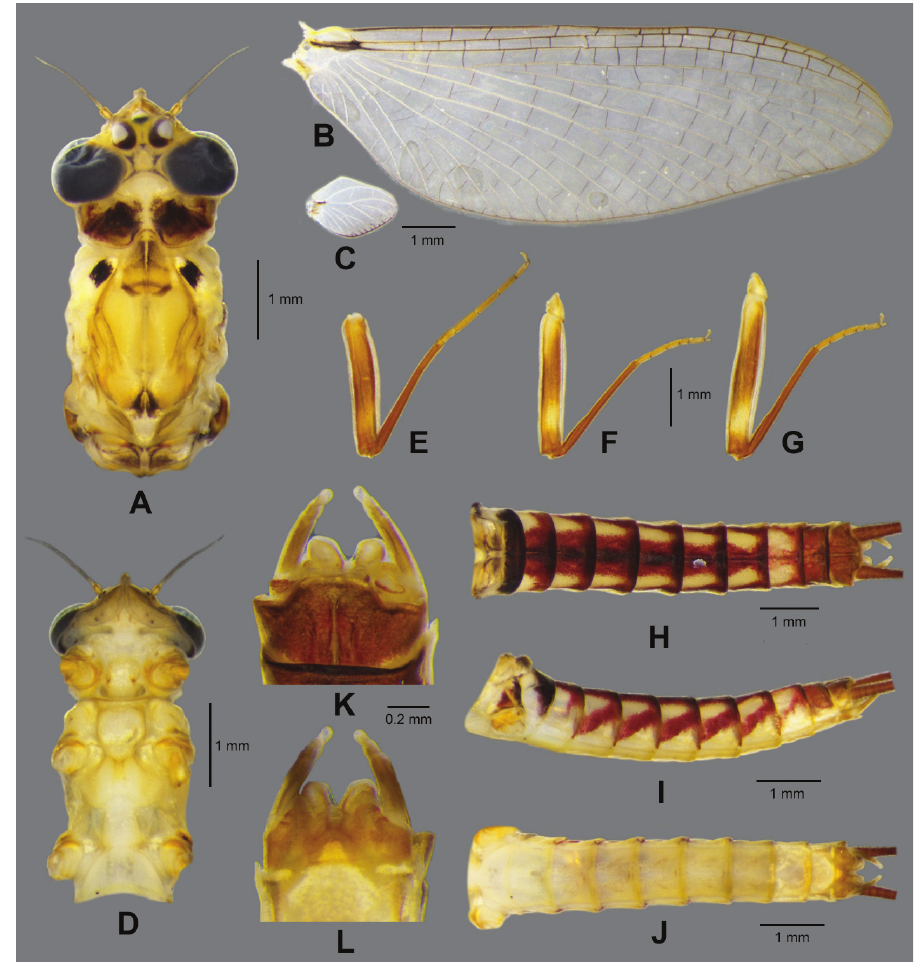
Figure 7. Paegniodes sapanensis sp. nov., male subimago A head and thorax (dorsal view) B forewing C hindwing D head and thorax (ventral view) E foreleg F middle leg G hind leg H abdomen (dorsal view) I abdomen (lateral view) J abdomen (ventral view) K genitalia (dorsal view) L genitalia (ventral 2.8 mm; tibia 2.2 mm; tarsus 1.2 mm (tarsal segments in order of decreasing length: 1≥5>2≥3>4). Each leg with two claws; one blunt, and one sharp and hooked. Abdomen . Dorsally with ornamentation as in Fig. 7H, tergum I with transverse dark band, terga II–VII with distinct, reddish median band; laterally with pattern as in Fig. 7I, with clearly oblique stripes on terga III–VII but those on terga II and VIII less visible; all sterna predominantly light yellow (Fig. 7J). Combined length of two terminal segments of gonopods half the length of basal one (Fig. 7K, L). Penis lobes jointed at base, apices separated, each penis lobe apex slightly expanded laterally. Styliger plate with concave posterior margin, but median part convex (Fig. 7L). Cerci reddish to brown.